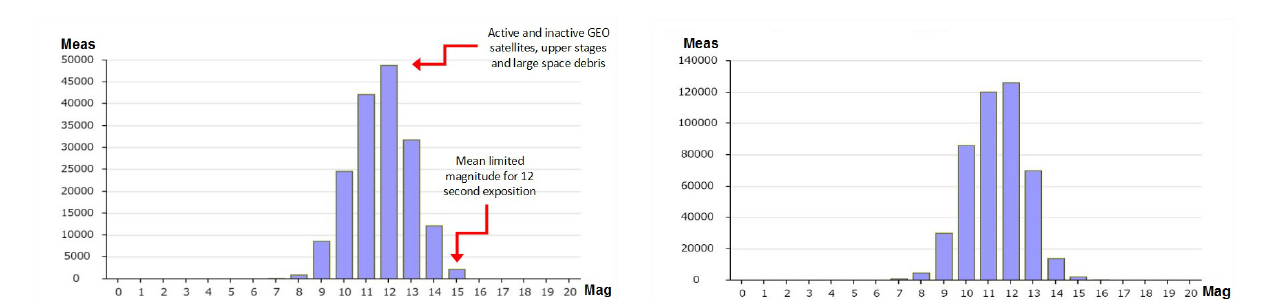
Figure 11. Magnitude distribution of ORI-25 measurements at Cos- ala, January 2016–September